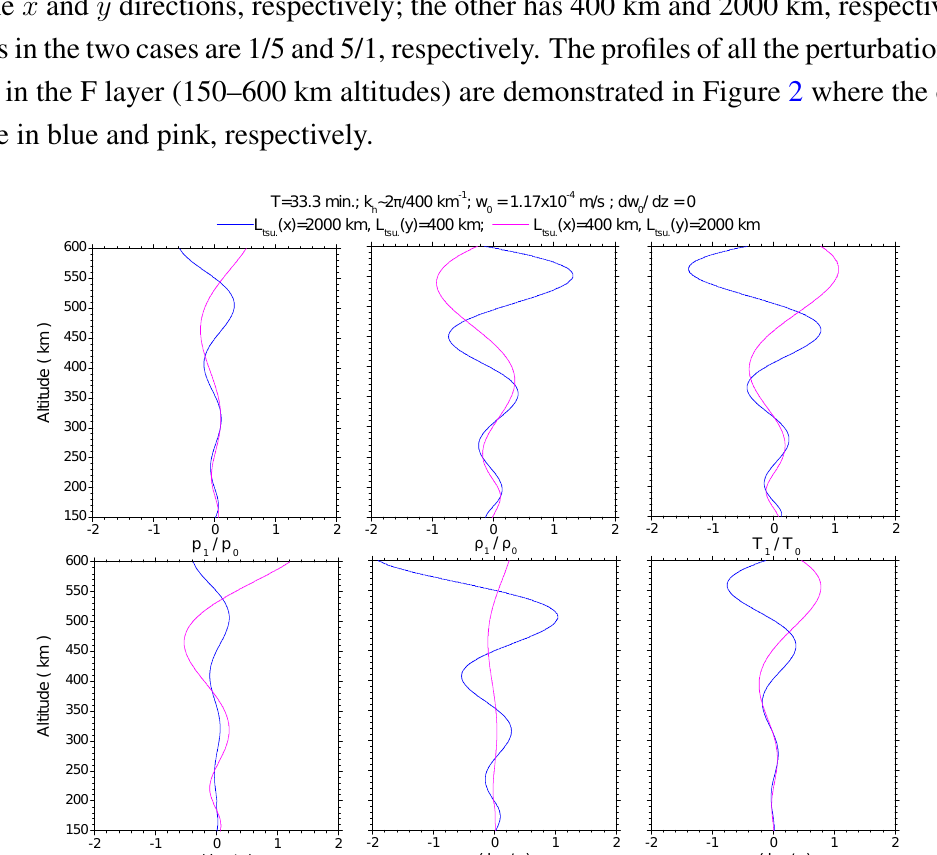
= 1 . 17 × 10 − 4 m/s 0 / d z = 0 . Wave period, 2 π / ω , is 33.3 min, 0 ∼ 400 km, is considered [11] in two cases of h